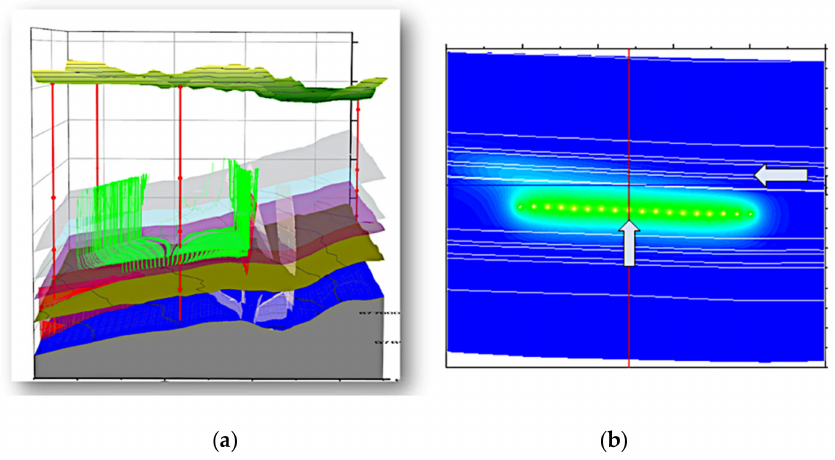
Figure 10. ( a ) Exemplary 3D particle tracking model used for the assessment of release pathways through seismic faults; ( b ) exemplary 2D simulation used for the assessment of the impact of hydrogeologic conditions on the retention capacity of the host